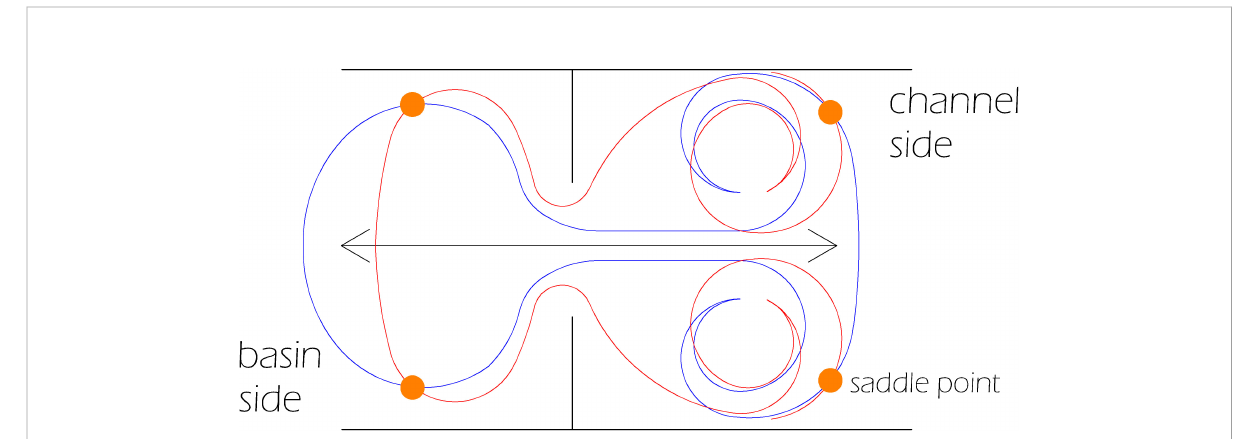
FIGURE 8 Sketch of forward and backward structures in red and blue, respectively. Their concurrent presence in the inlet generates shear LCSs. Their length and size tend to increase and shrink recursively in time in agreement with the tidal